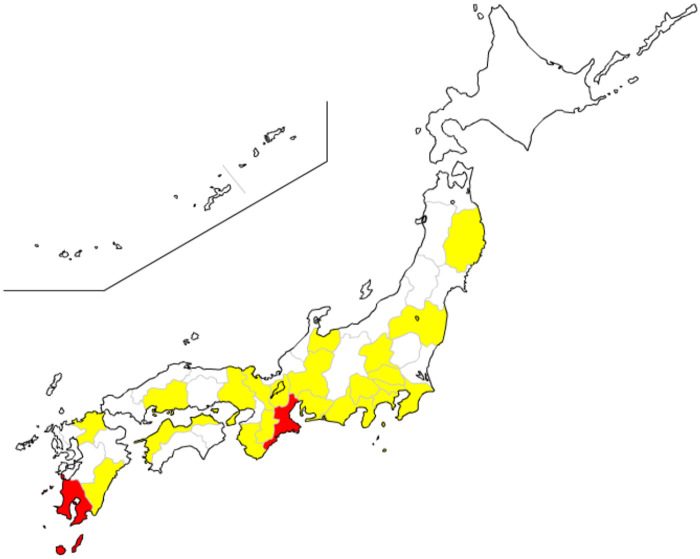
Location of sample collected and diagnosed as SFTS.The map indicates the provinces/prefectures (yellow) where samples were collected and where cats were diagnosed as SFTS (red).